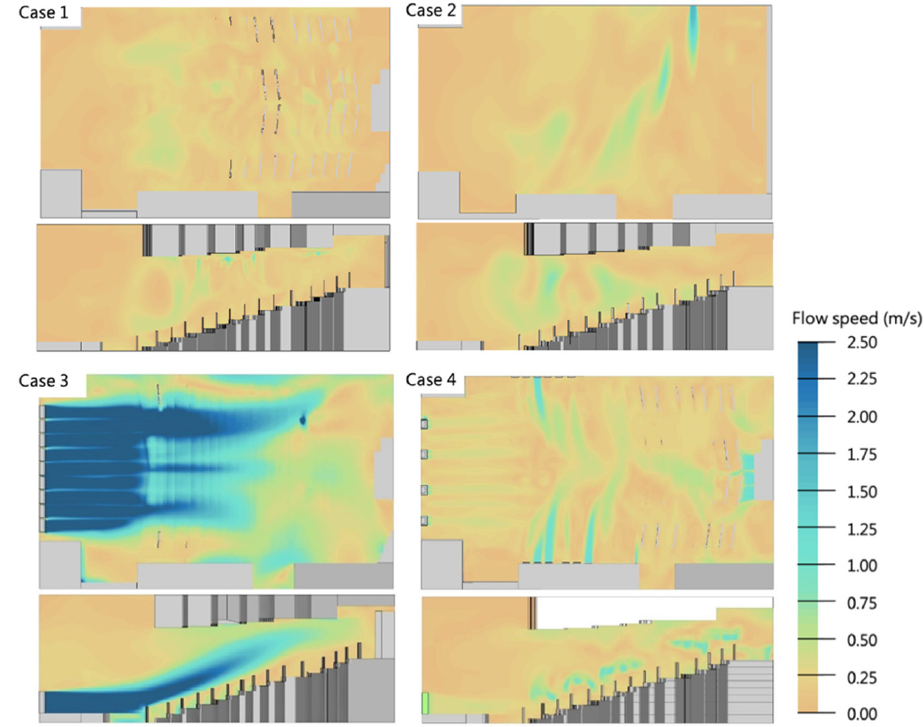
Figure 16. Temperature distribution of each case.